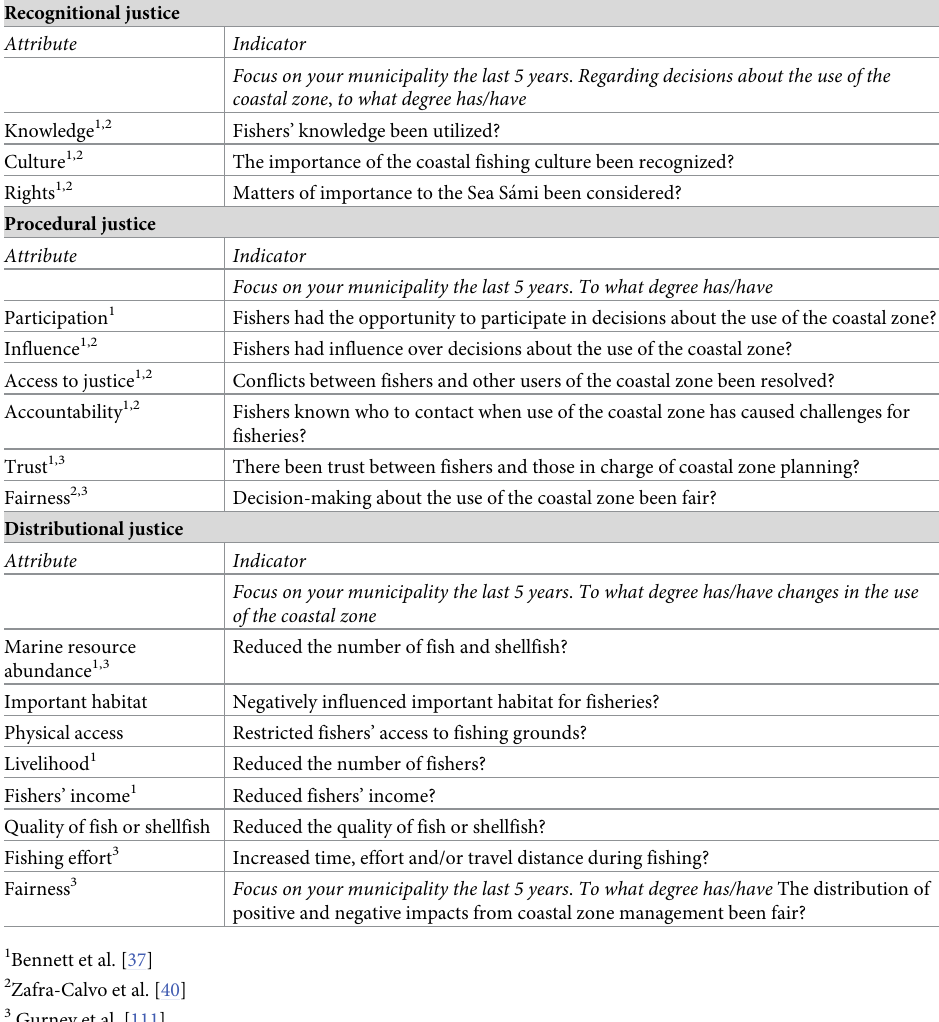
Table 1. Survey indicators of blue justice for small-scale fisheries in coastal zone planning and